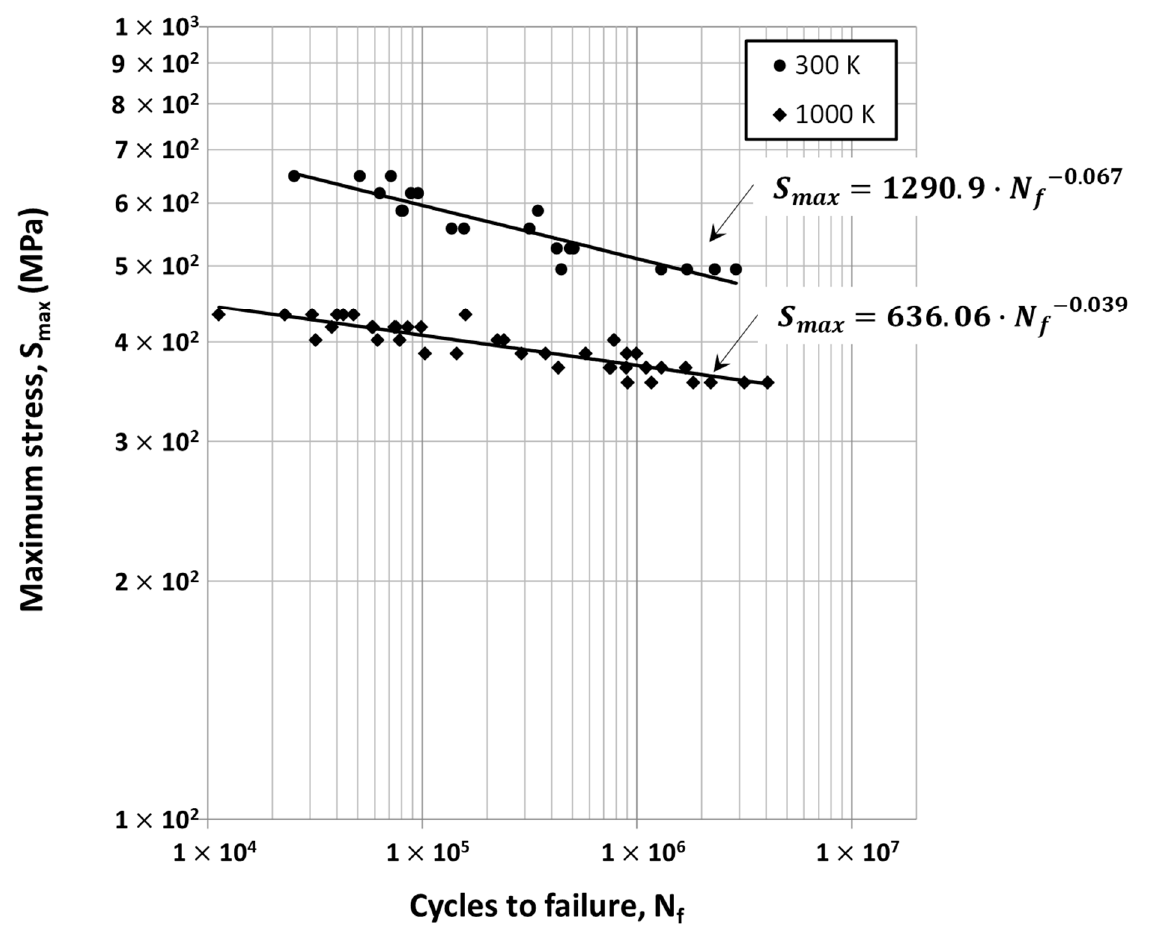
Figure 6. S–N plots for all fatigue data tested at RT and 1000 K. Table 3. Modified fatigue strength at 10 6 cycles with various standard deviations.